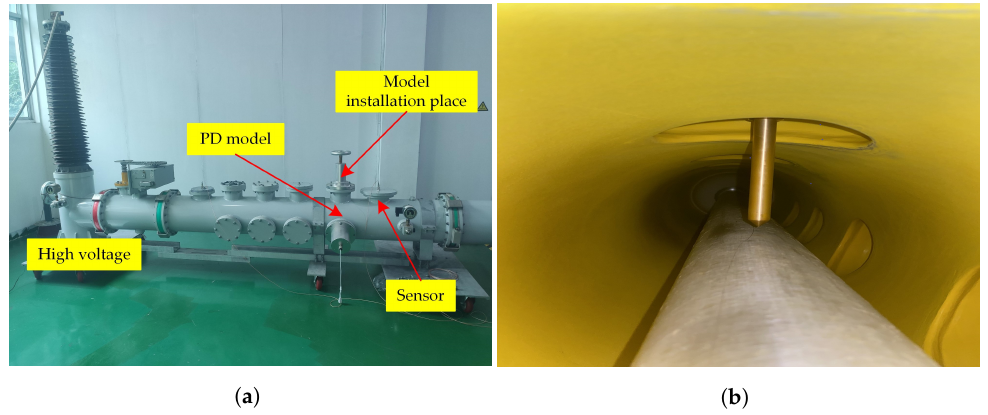
Figure 4. PD experiment platform and inside the experiment platform: ( a ) PD experiment platform; ( b ) inside the experiment